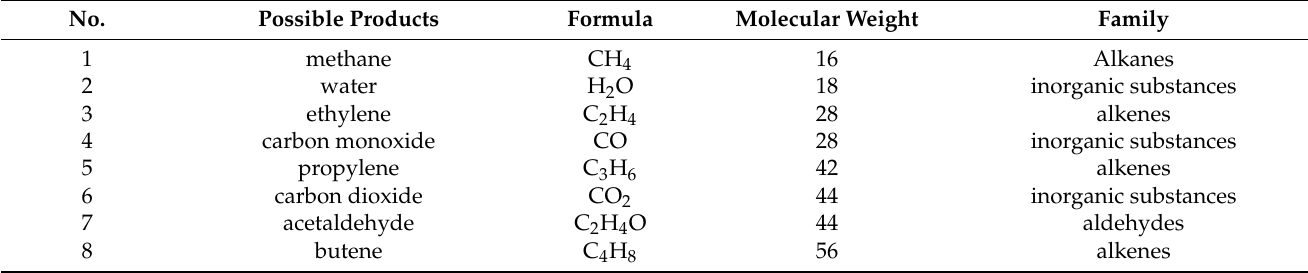
Table 1. Product distributions of C 1–6 molecules from pyrolysis of disposable mask layers. Repro- duced with permission from Ref. [32]. Copyright 2021 Elsevier